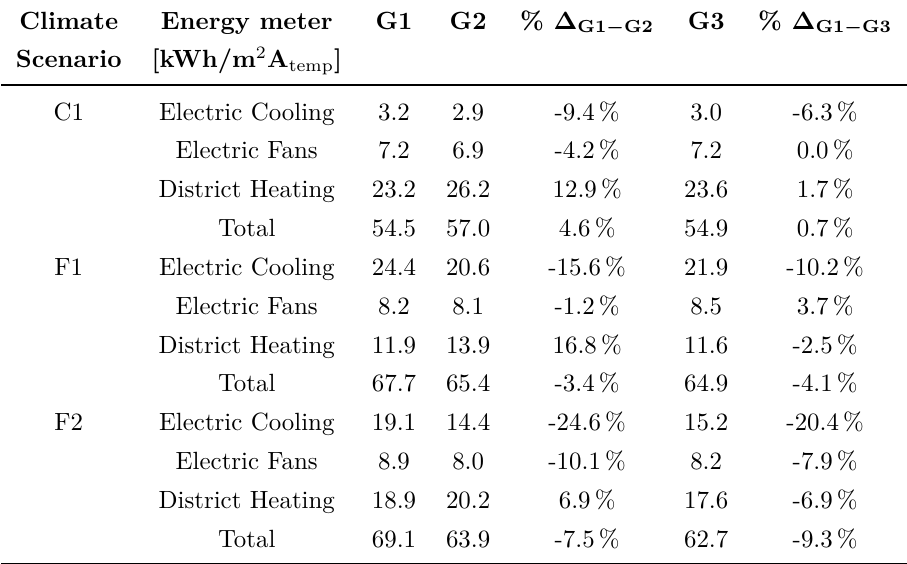
Table 4. Annual building energy consumption in the different years for each